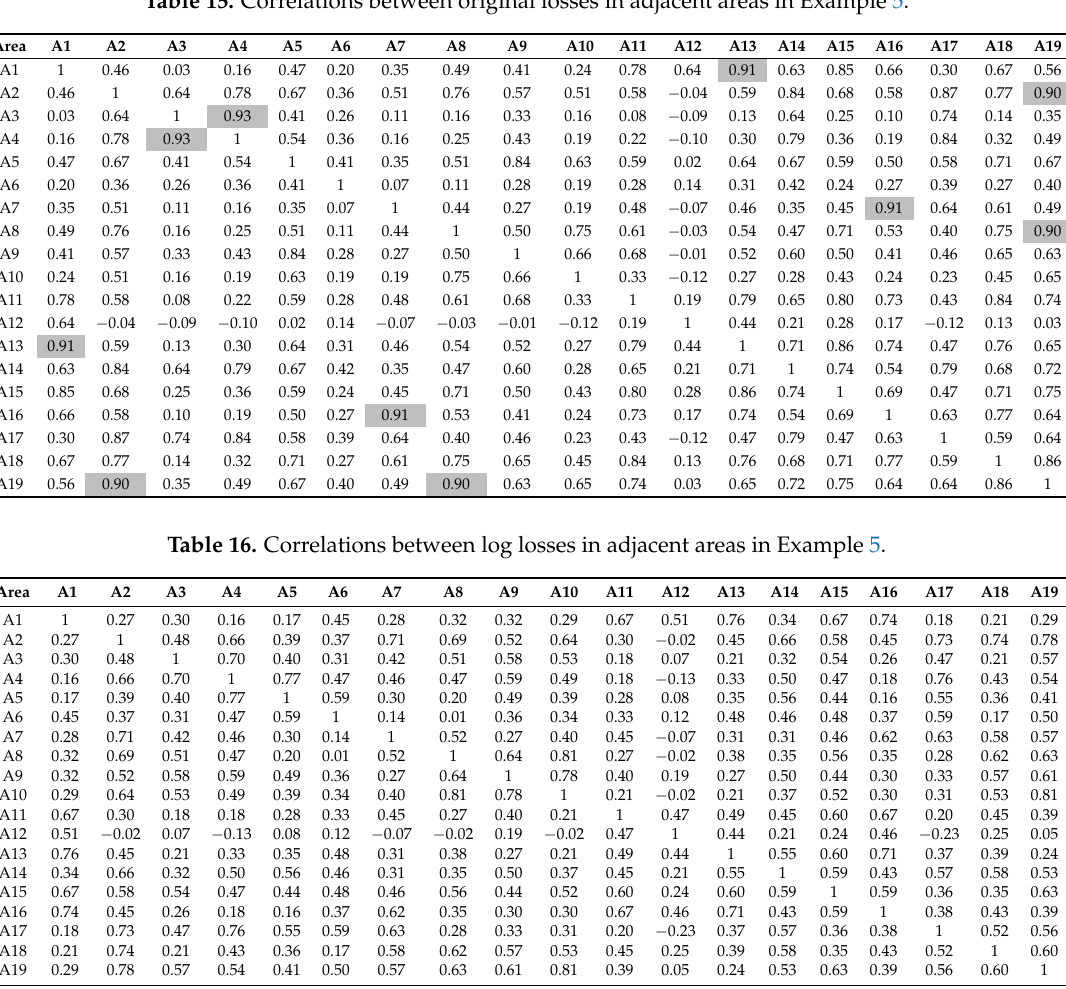
Table 15. Correlations between original losses in adjacent areas in Example 5.